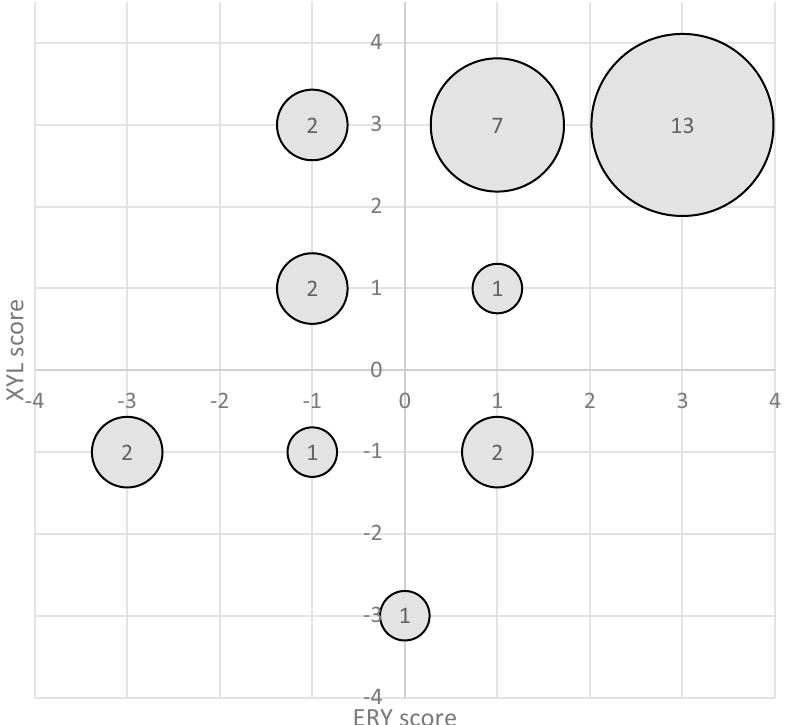
Figure 4. Distribution of S. pyogenes PTA isolates based on combined polyol effectivity scores (PES) for ERY and XYL. PES was calculated as a summary effect of three polyol concentrations (2.5%, 5% and 10%), where each polyol concentration contributed − 1, 0 or + 1 points depending on whether the S. pyogenes isolate growth increased, remained unchanged or decreased in the presence of the polyols, respectively. Size of the bubble represents number of isolates with different scores.